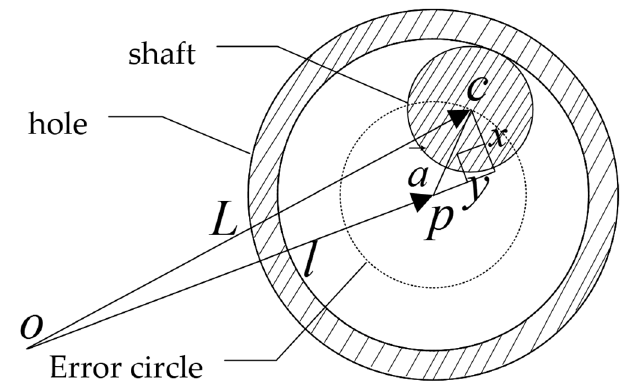
Figure 5. Joint clearance vector image.